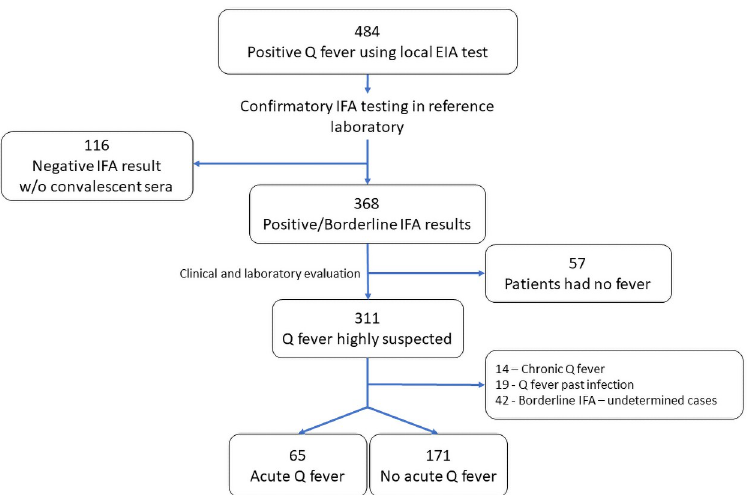
Fig 1. Explanation regarding inclusion and exclusion of